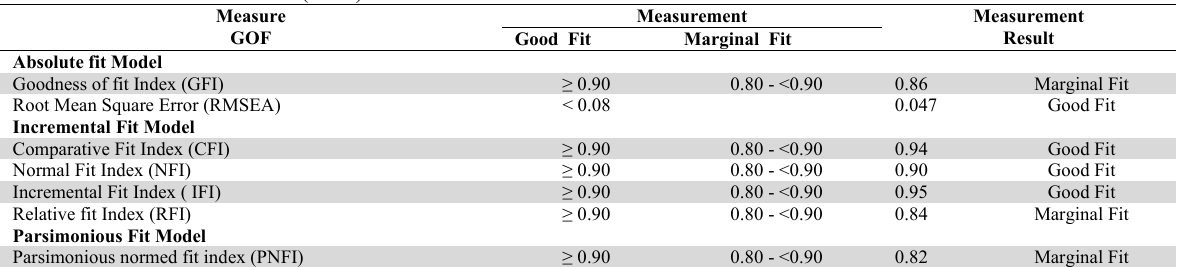
The results of Goodness of FIT